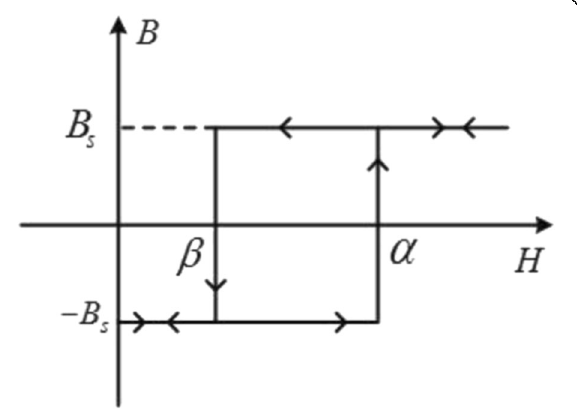
Fig. 1 Magnetization characteristics of the magnetic dipole